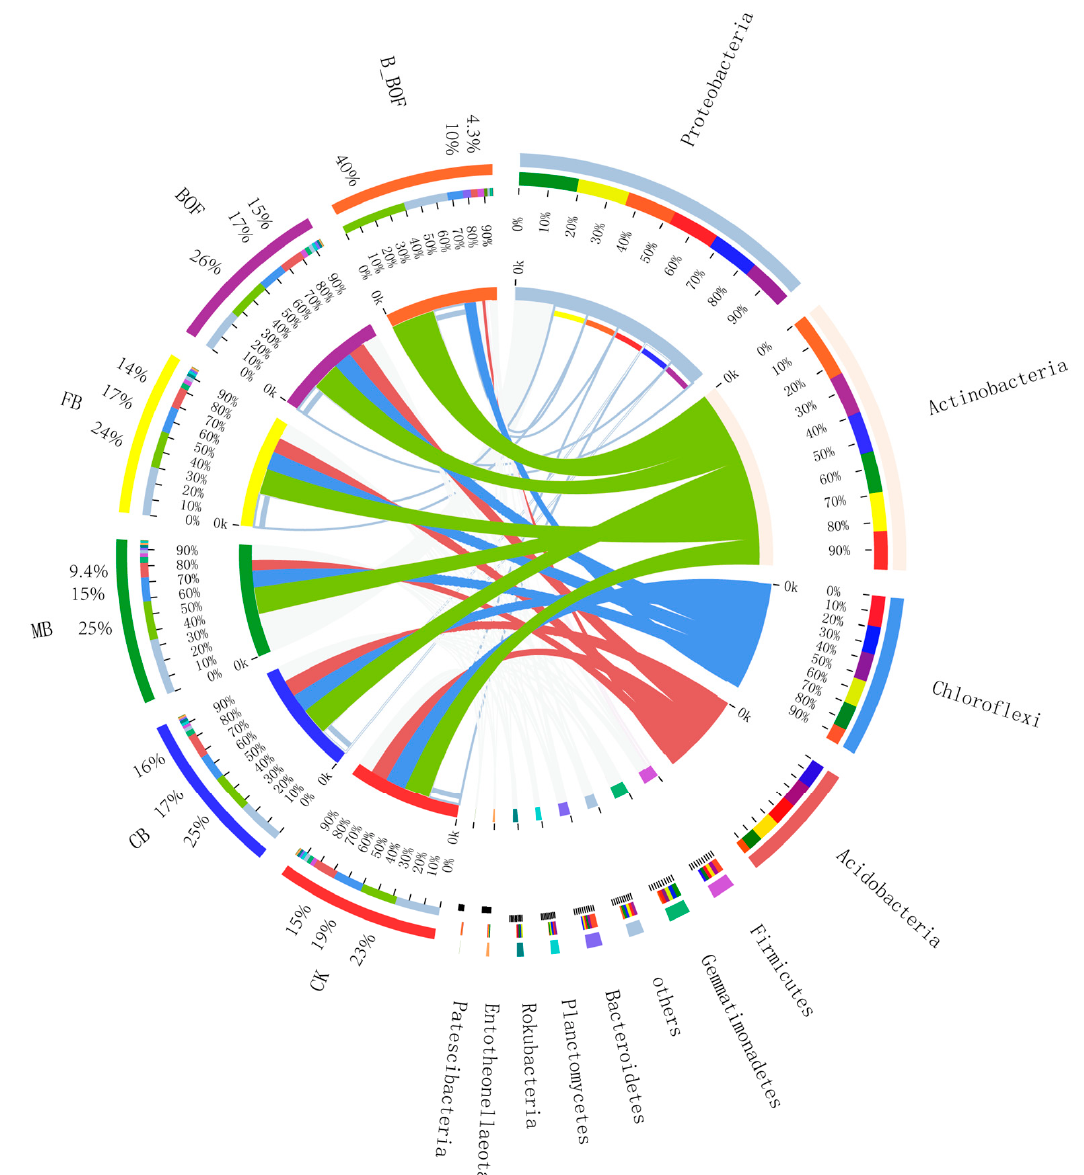
Figure 3. Relative abundance of bacteria in each sample at the phylum level. The green band is Actinobacteria, the red band is Acidobacteria, and the blue-purple band is Chloroflexi.